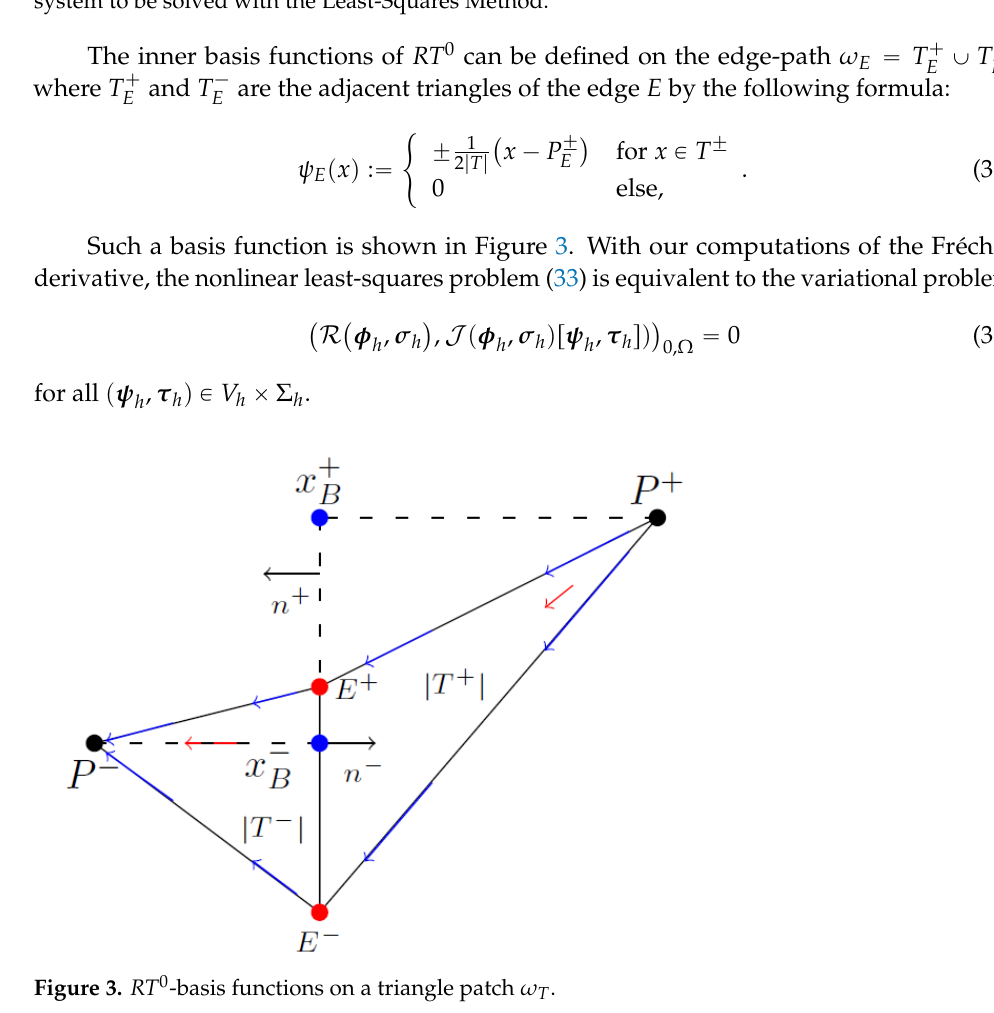
Figure 2. Local degrees of freedom by using P 1 - and RT 0 bases in the discretization of the first-order system to be solved with the Least-Squares Method.